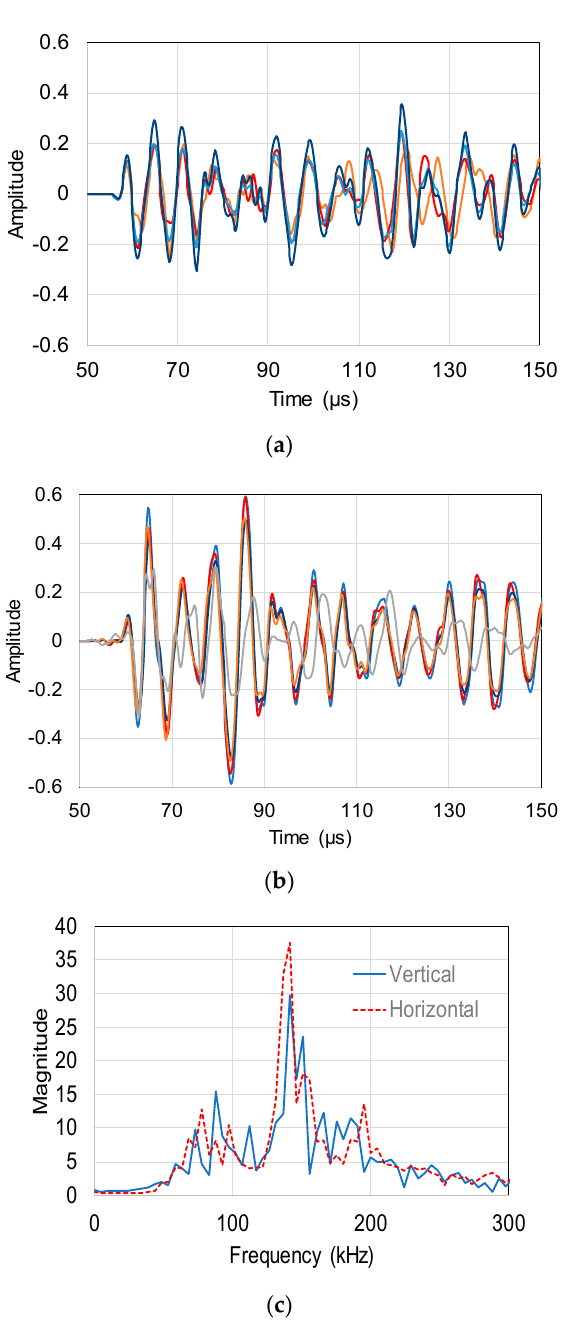
Figure 13. Individual waveforms received by Pico (5 mm) sensor in the case of ( a ) horizontal excitation; ( b ) vertical ( c ) the average FFT curves of previous waveforms.